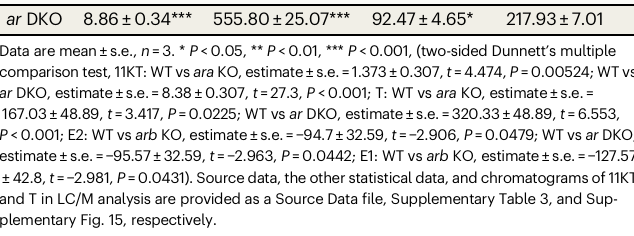
Table 2 | LC/MS analysis of androgen and oestrogen in brains 11KT (ng/g) 0.48±0.11